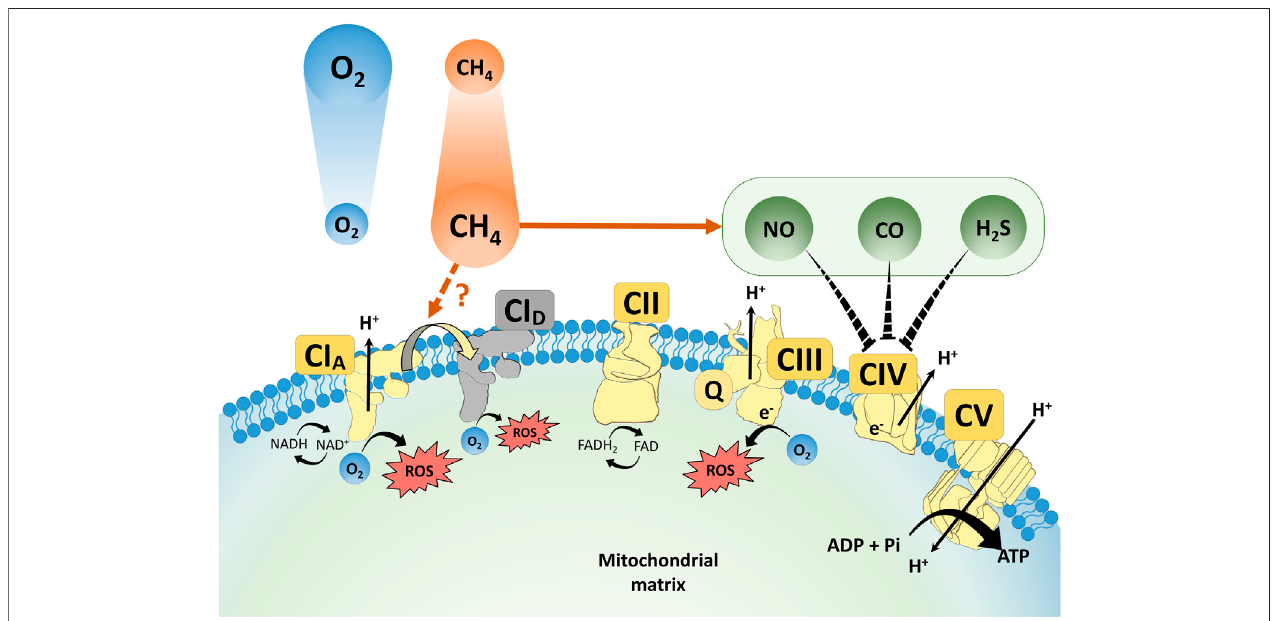
FIGURE 2 | A scheme for the proposed interaction of CH 4 , NO, CO and H 2 S at mitochondrial respiratory complexes. ROS: reactive oxygen species; NO: nitrogen monoxide; CO: carbon monoxide; NAD/NADH: nicotinamide adenine dinucleotide/dihydronicotinamide adenine dinucleotide; CI – V: Complex I – V; TCA cycle: tricarboxylic acid cycle; FAD/FADH 2 : fl avin adenine dinucleotide/dihydro fl avine-adenine dinucleotide; Q: ubiquinone.